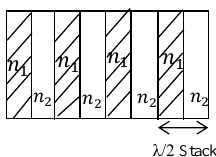
FIG. 2. Schematic of the multimode notch filter with a multilayer structure